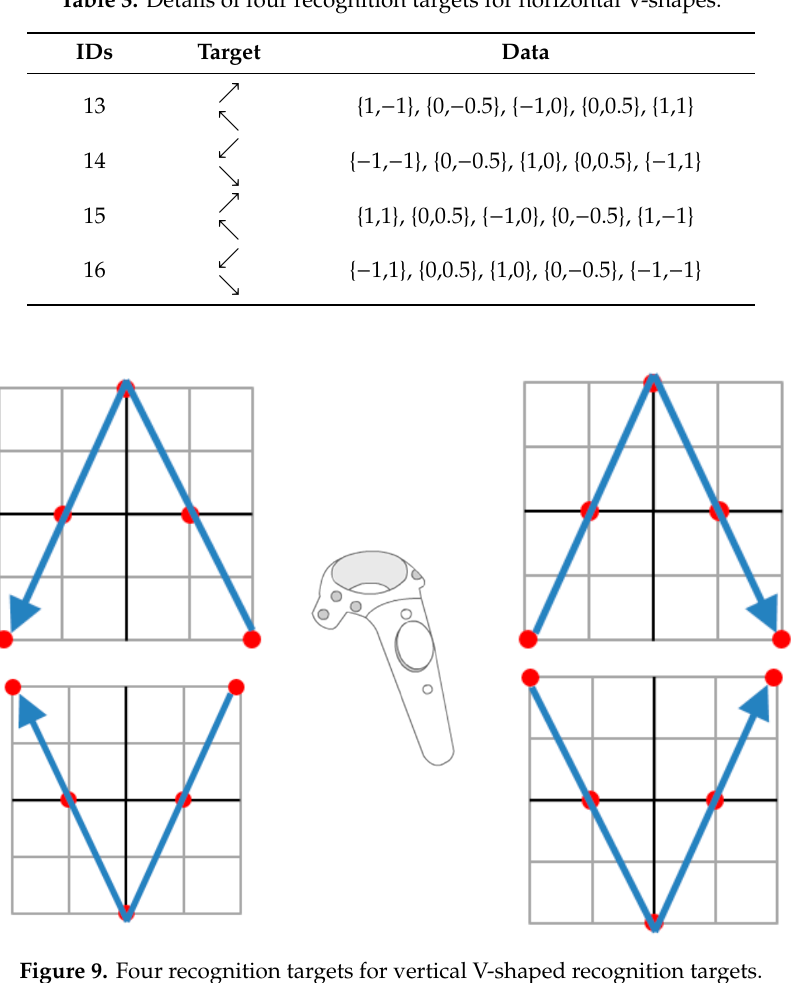
Figure 9. Four recognition targets for vertical V-shaped recognition targets. Mathematics 2020 , 8 , x FOR PEER REVIEW